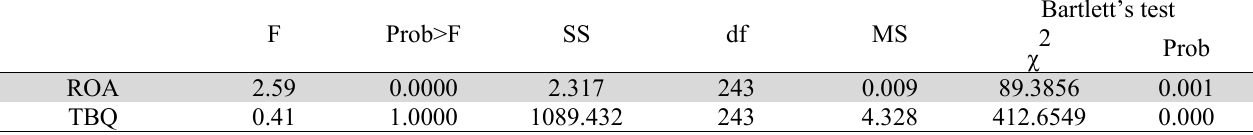
The ANOVA and Bartlett’s